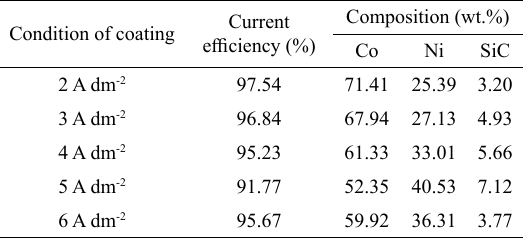
Table 2. Cathodic current efficiency and composition of the nanocomposites. Condition of